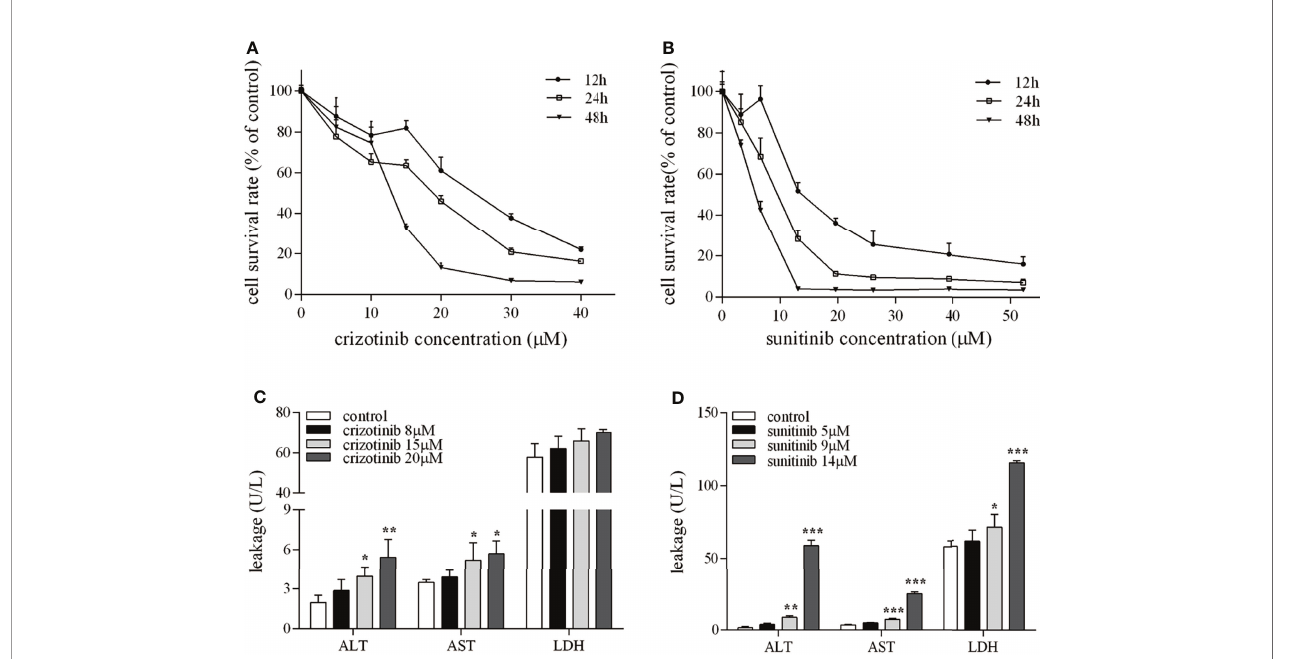
FIGURE 1 | The hepatotoxicity of crizotinib and sunitinib in vitro . (A, B) Cytotoxicity of crizotinib or sunitinib alone at the various concentration for 12, 24 and 48 h in HepG2 cells (n=5-6). (C, D) ALT, AST and LDH levels in the supernatant following HepG2 cell treatment with crizotinib or sunitinib at different concentrations for 24 h (n = 3). *P < 0.05, **P < 0.01 or ***P < 0.001 (the crizotinib or sunitinib alone vs. control). ALT, alanine aminotransferase; AST, aspartic acid transferase; LDH, lactate